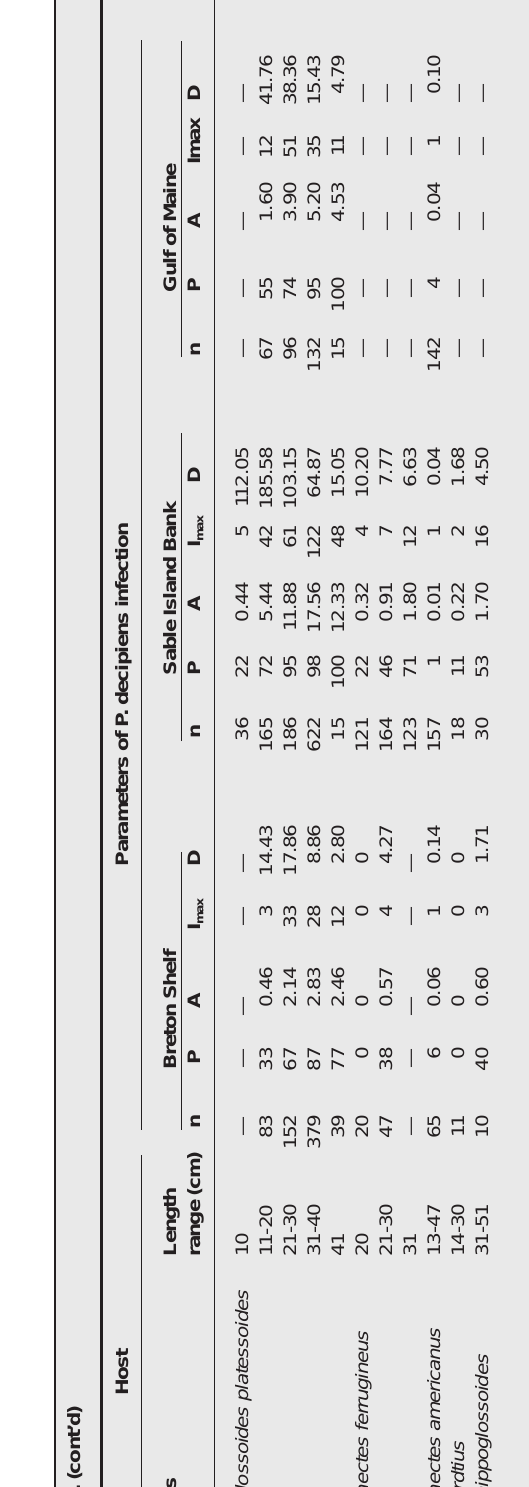
of 373 sealworm were found in the body cavity, and 114 (31%), in the napes. Of 1,435 larvae in Sable Island Bank cod >70 cm in length — (n=24), 318 (22%) occurred in the body cavity, and 668 (47%), in the napes; 385 (20%) and 532 (27%) of 1,967 larvae respectively occu- pied the body cavities and napes of 13 Sable Island Bank sea raven > 41 cm in length. In the Gulf of Maine, 246 (70%) of 350 P. decipiens from 12 cusk >50 cm in length, and 54 (70%) of 77 from 24 white hake >60 cm in length were recovered from the napes. High frequen- cies of sealworm in body cavities and napes were not unique to larger fish. In a 1990 sample of mailed sculpin from Sable Island Bank, 17 (11%) of 161 larvae infecting 12 to 15 cm fish (n=20) occurred in the body cavity, and the same number in the napes. Sixteen (31%) of 52 nematodes were found on the ovary, or free in the body cavity of 5.6 to 9.5 cm spiny lump- sucker (n=84) sampled from Sable Island Bank in October ’91. ANOVA revealed that geographical disparities in prevalence and/or abundance of sealworm were significant ( P < 0.01) in 14 of 20 host species sampled in at least two of the three sur- vey areas (Table 2). Levels of infection in sam- ples from Sable Island Bank were significantly greater than those found in Breton Shelf sam- ples in 10 of 14 species contrasted, and also ex- ceeded those recorded in samples of 11 of 17 corresponding host species from the Gulf of Maine. Contrasts of Breton Shelf and Gulf of Maine samples, however, indicated that among 11 species common to both areas, only grey sole ( Glyptocephalus cynoglossus ) and plaice differed significantly in regard to parameters of sealworm infection. Invariably, spatial dispari- ties in infection levels in four lightly infected hosts, silver hake ( Merluccius bilinearis ), wolffish ( Anarhichas lupus ), redfish ( Sebastes fasciatus ) and winter flounder, were not signifi- cant. Plaice was the only host species in which sealworm prevalence and abundance differed significantly in each of the three survey areas. Contrasts of 1986-87 (McClelland et al. 1990) and 1989-90 samples (herein) indicate that ap- parent increases in sealworm infection parame- ters in 8 of 10 host species from Sable Island Bank were statistically significant (Table